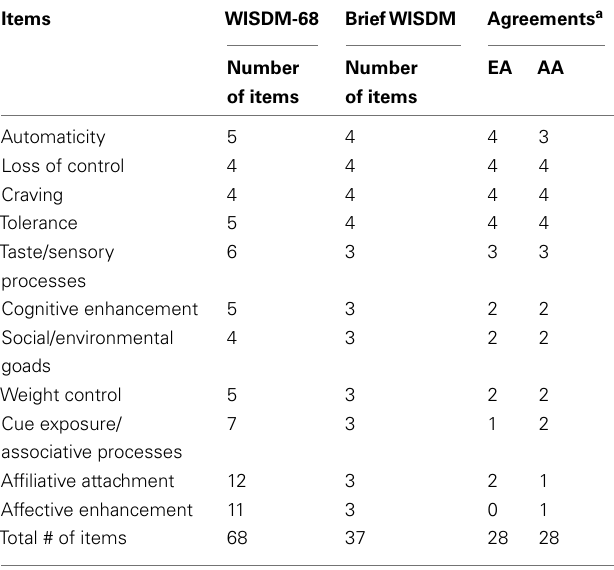
Table 4 | Evaluation of the items tapped by the BriefWISDM